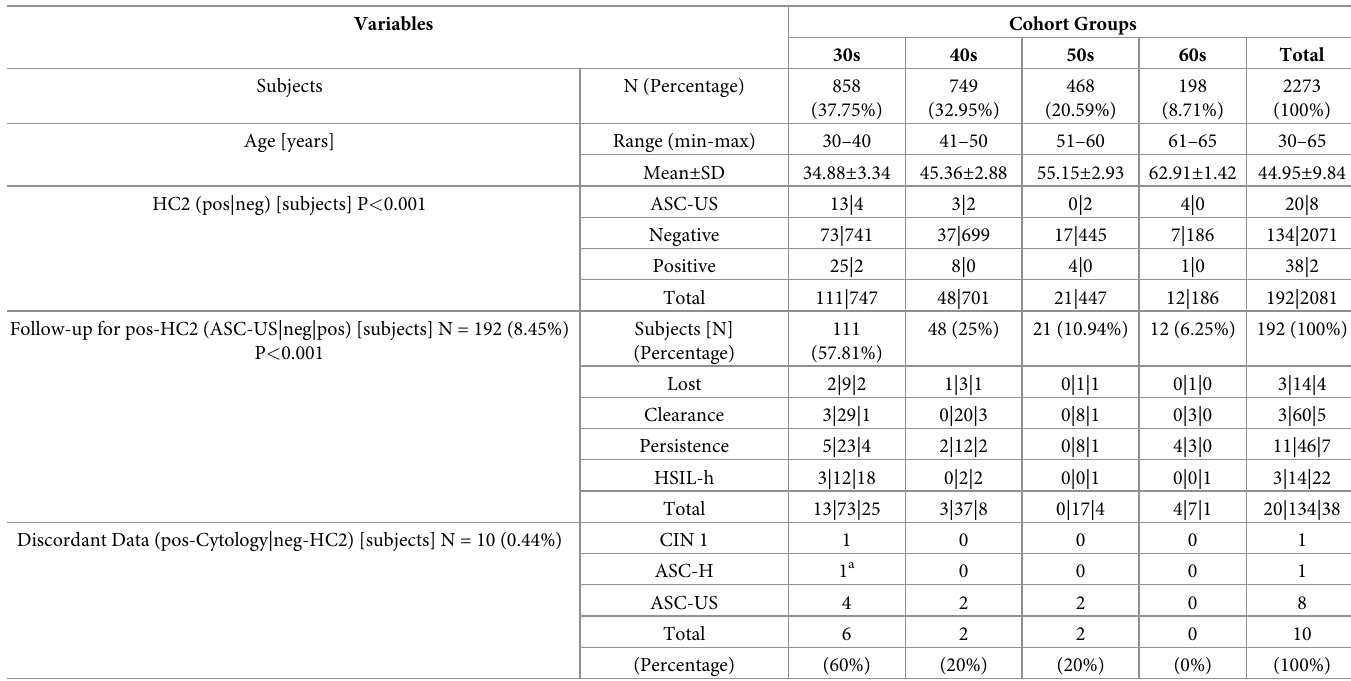
Table 1. Study cohort descriptive